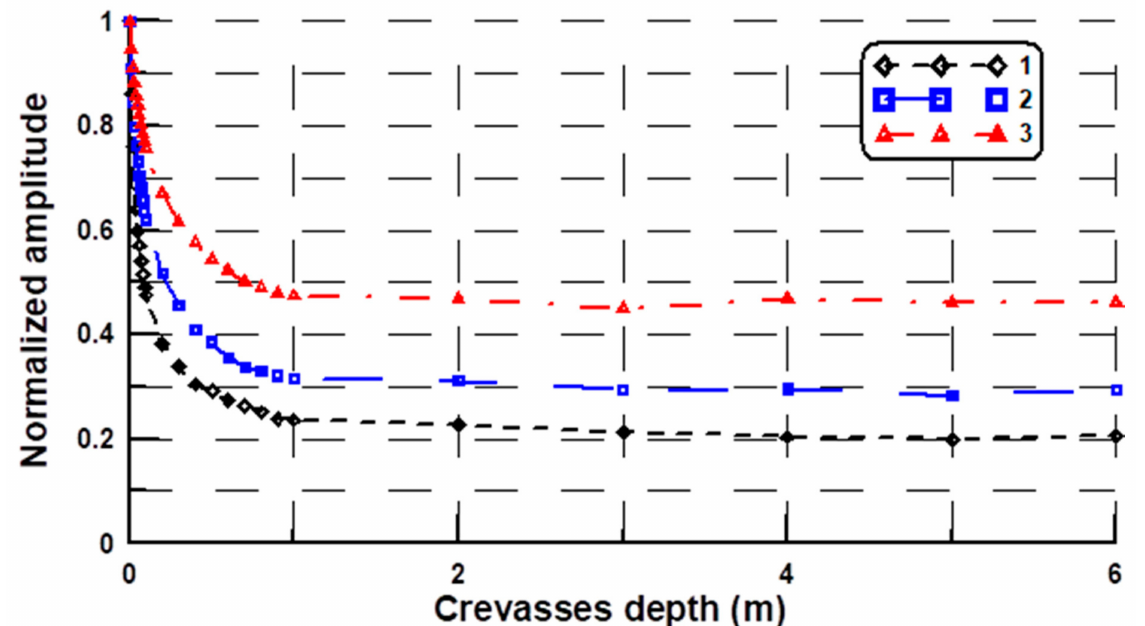
Figure 7. The average normalized amplitude (7) of the gravity waves in the water channel with the crevasse-ridden bottom (Figure 6) versus the depth of the crevasses. Curves 1–3 were, respectively, obtained for the following periodicities of the crevasse locations (1) ∆ l cr = 1 km; (2) ∆ l cr = 2 km; (3) ∆ l cr = 4 km. The width of the crevasses w cr was equal to 0.5 km. The number of eigenmodes n 0 in Equation (7) is equal to